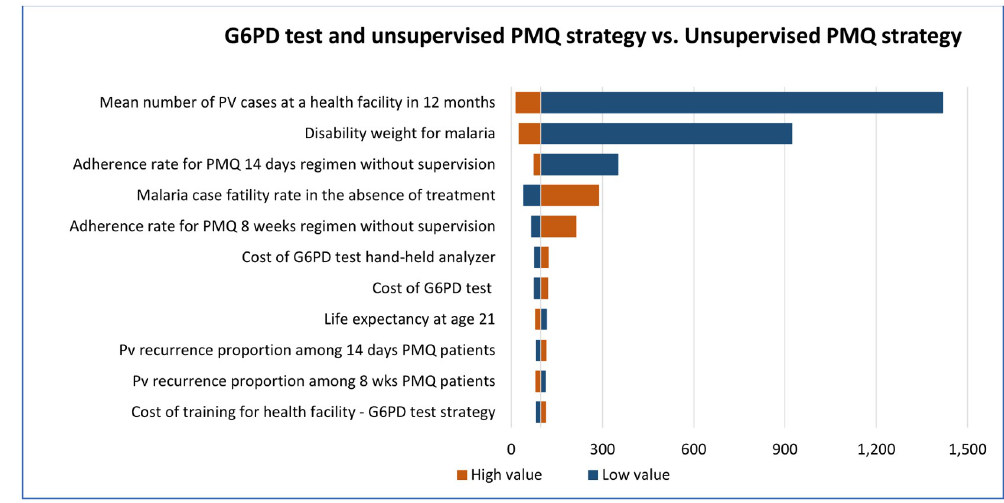
Fig 8. Deterministic one-way sensitivity analysis for G6PD test with unsupervised PMQ strategy against unsupervised PMQ strategy. The vertical central line represents the base case ICER.